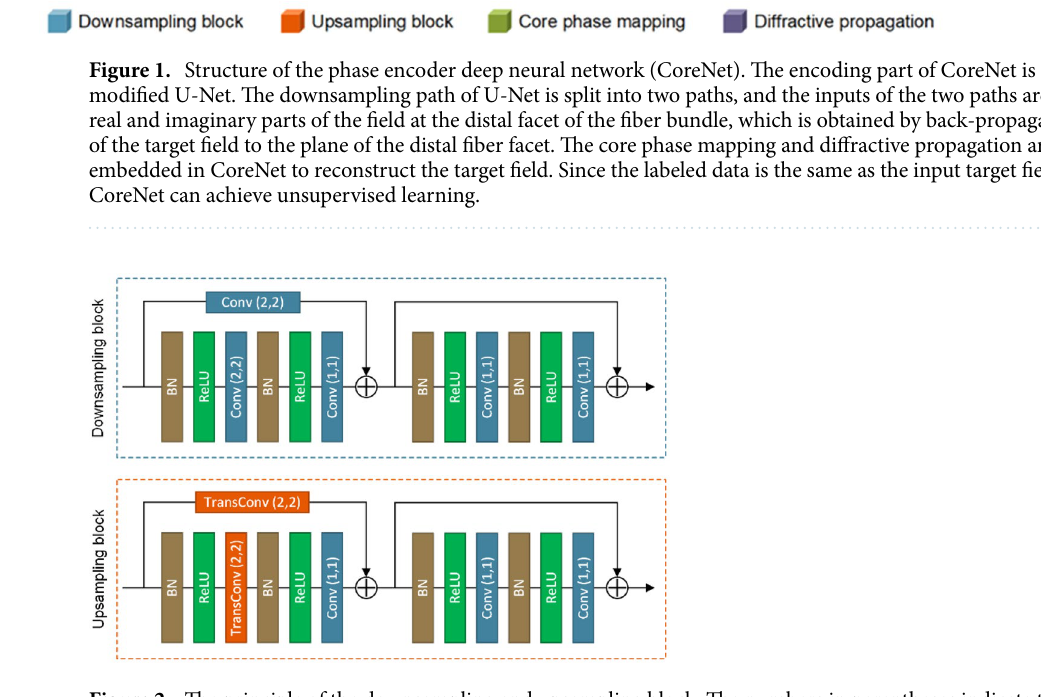
Figure 2. The principle of the downsampling and upsampling block. The numbers in parentheses indicate the strides of convolution layers and transposed convolution